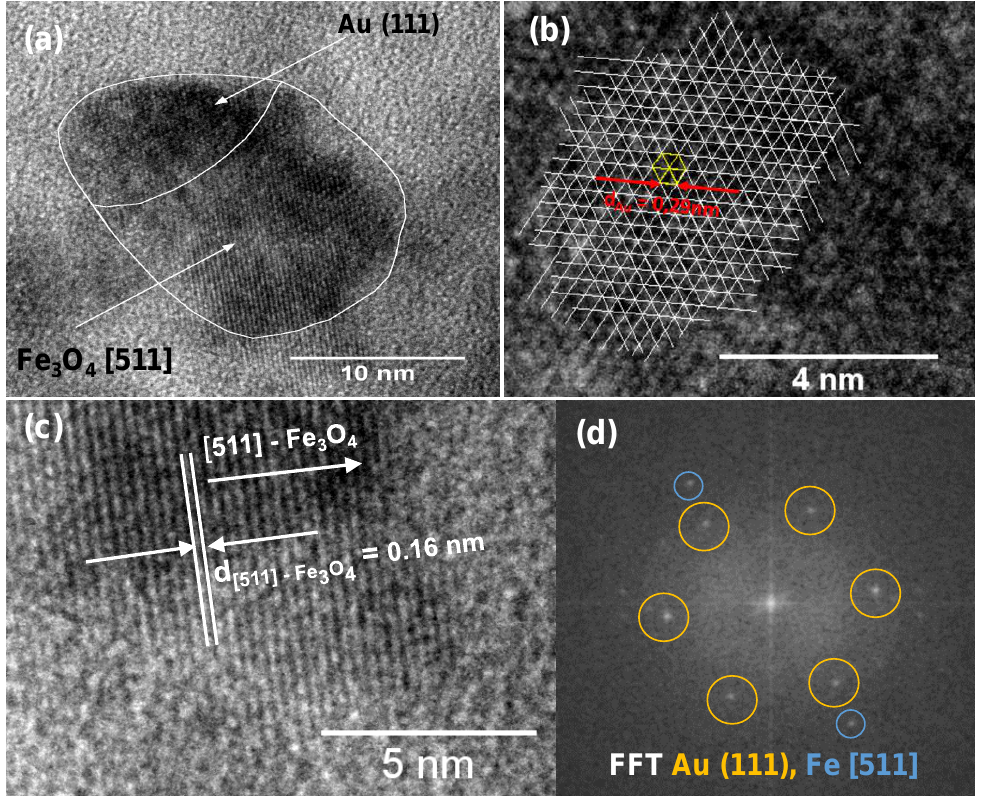
Figure 3. ( a ) HRTEM image of a Fe 3 O 4 @Au pNP ( b , c ) with magnified sections, and ( d ) the fast Fourier transform (FFT) image.